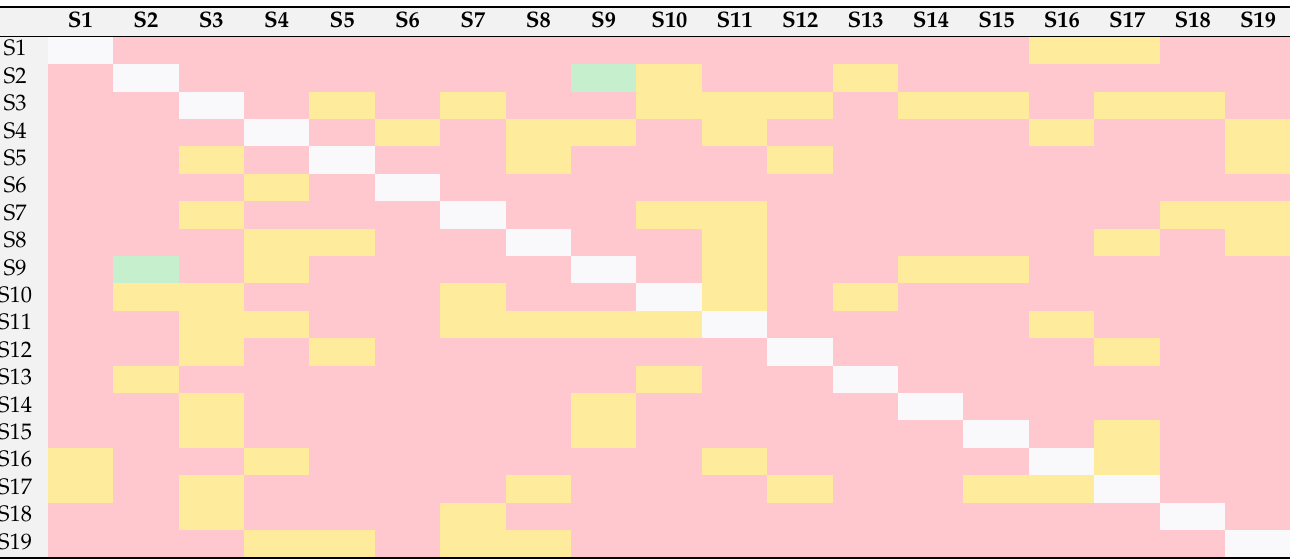
Table 2. Graphical interpretation of the correlation